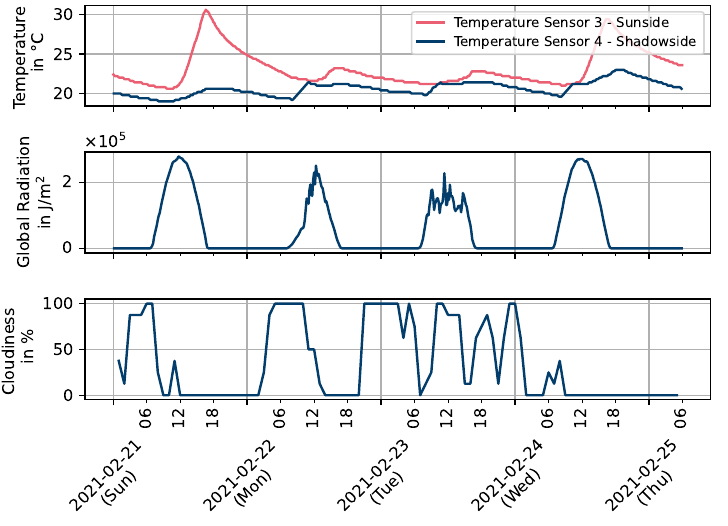
Figure 10. Comparison of temperature measurements in two rooms with different orientations and radiation